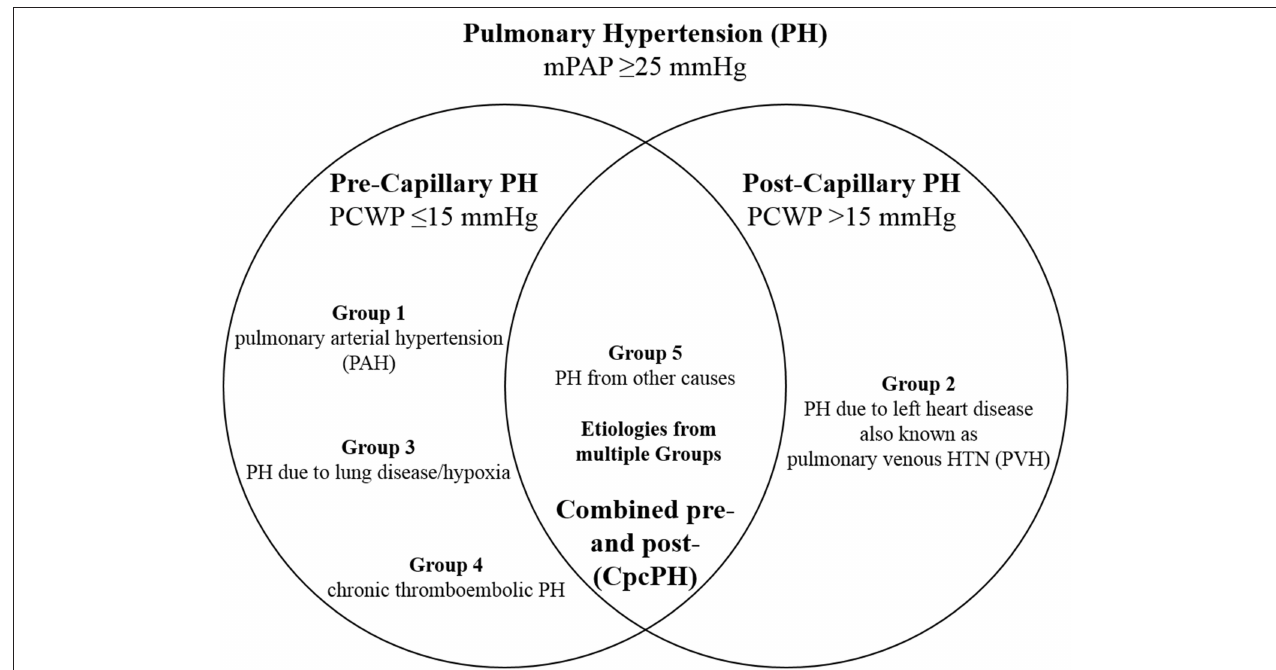
FIGURE 1 | Hemodynamic definitions of pulmonary hypertension (PH) and clinical group classification. Combined pre- and post-capillary pulmonary hypertension (CpcPH) is characterized by pulmonary venous hypertension (PVH), in addition to trans-pulmonary gradient > 7 mmHg or pulmonary vascular resistance > 3 Wood units. mPAP, mean pulmonary arterial pressure; PCWP, pulmonary capillary wedge pressure. Adapted from Dellegrottaglie et al.